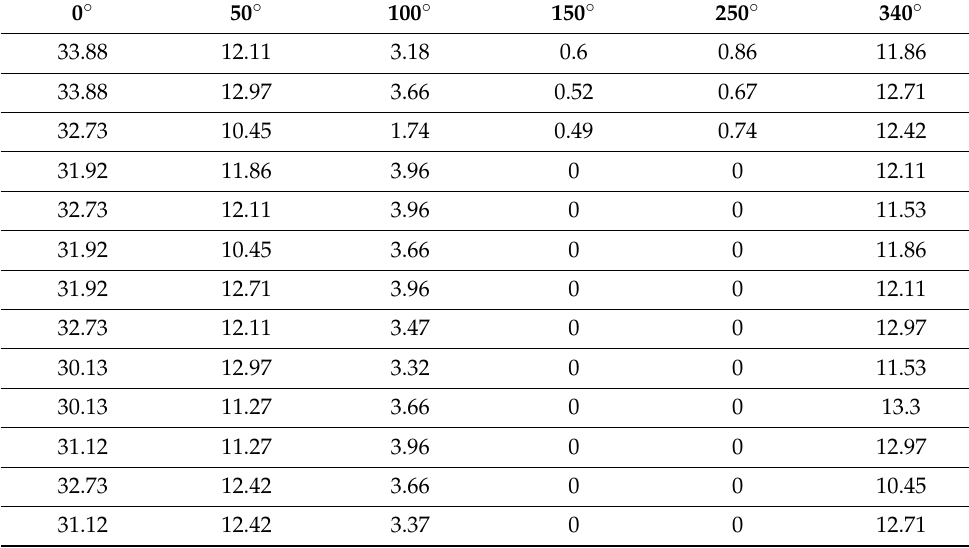
Figure 6. 0° Sense Data from Patch Antenna.